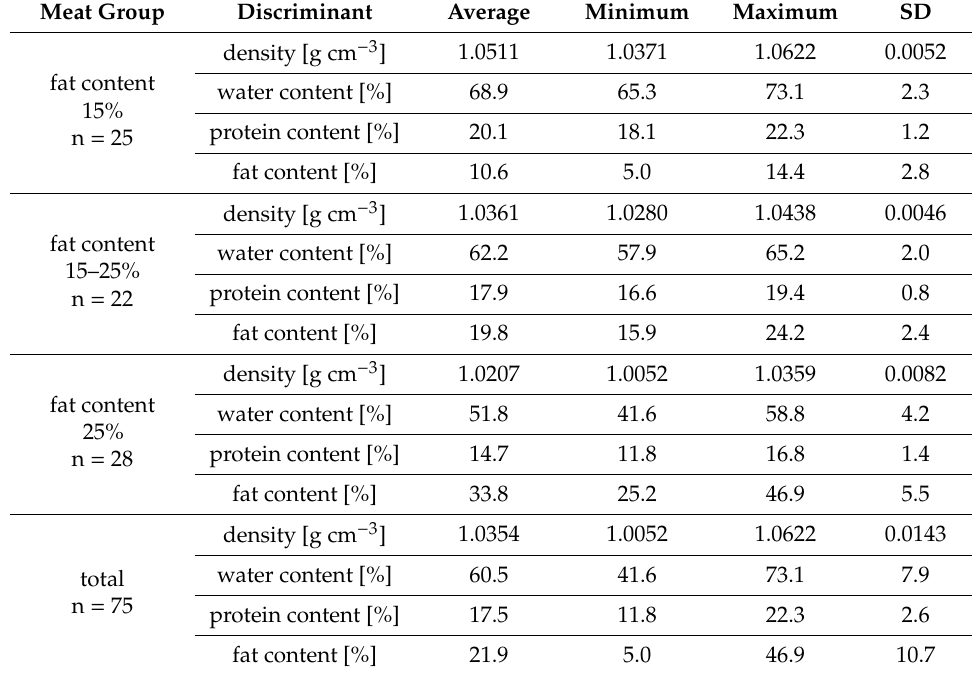
Table 1. Density, basic chemical composition and water sorption of the analyzed pork